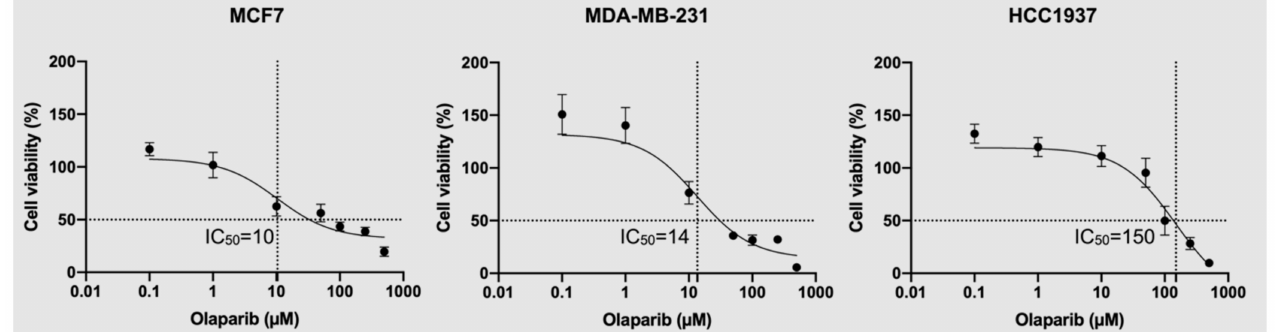
Figure 1. Corresponding MTS dose–response curves for MCF7, HCC1937, and MDA-MB-231 cells treated with ascending doses of olaparib (0.1–500 µ M) for seven days. The corresponding R 2 values for fitted dose–response curves in MCF7 (IC 50 = 10 µ M), MDA-MB-231 (IC 50 = 14 µ M), and HCC1937 (IC 50 = 150 µ M) cells were 0.89, 0.91, and 0.85,